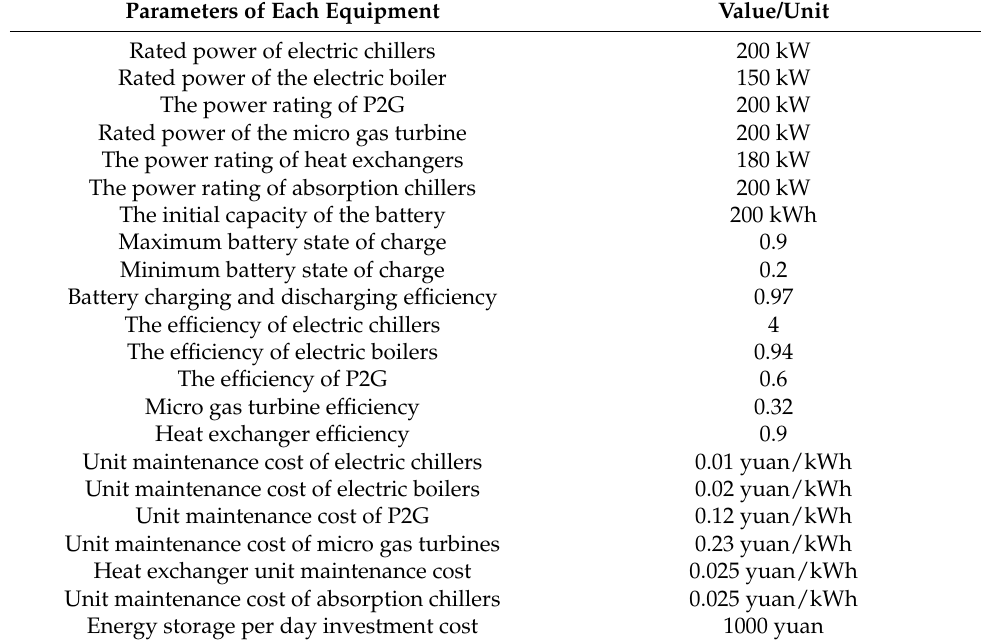
Table 1. System equipment parameters.